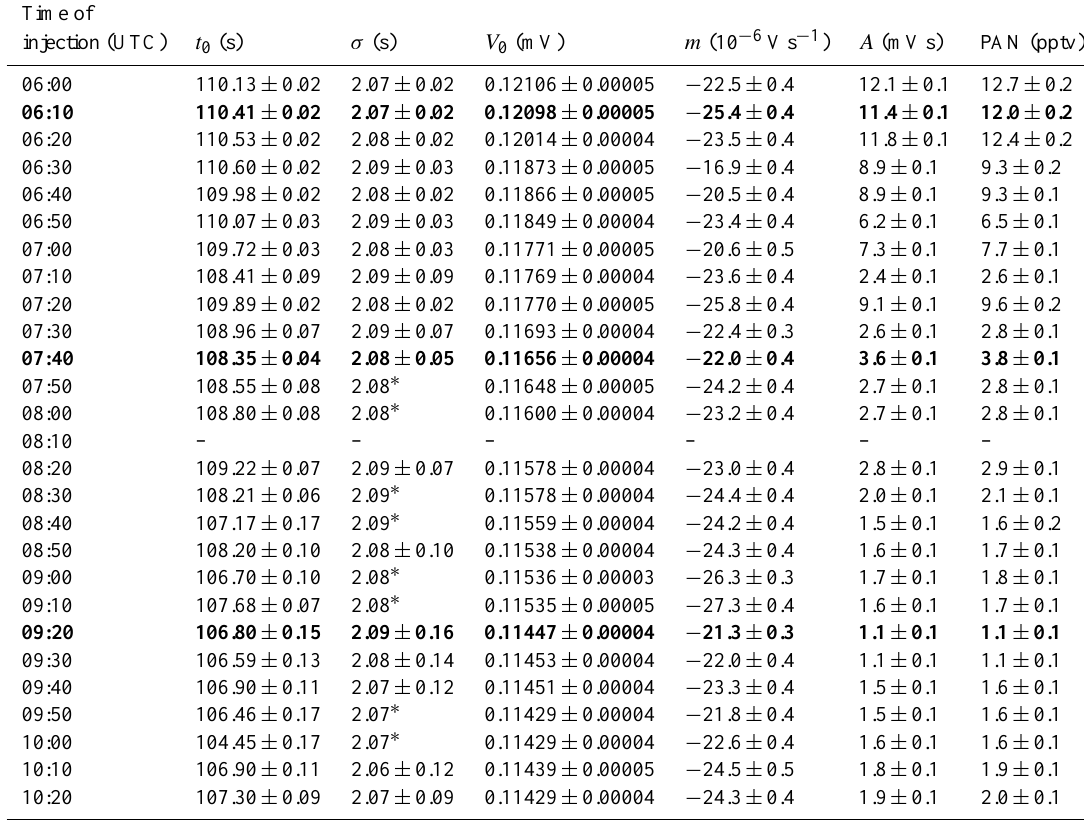
Table 12. Parameters of Eq. (1) fitted to a selection of PAN peaks in the chromatograms acquired during the night of 2 to 3 September 2013. Data for the peaks shown in Fig. 14 are highlighted in bold font. The errors are those reported by the IGOR software, except for the PAN mixing ratio, which was calculated by adding errors in the calibration uncertainty and the error in the peak area (reported by IGOR) in quadrature. Note that the fit of the peak in the 8:10 chromatogram did not